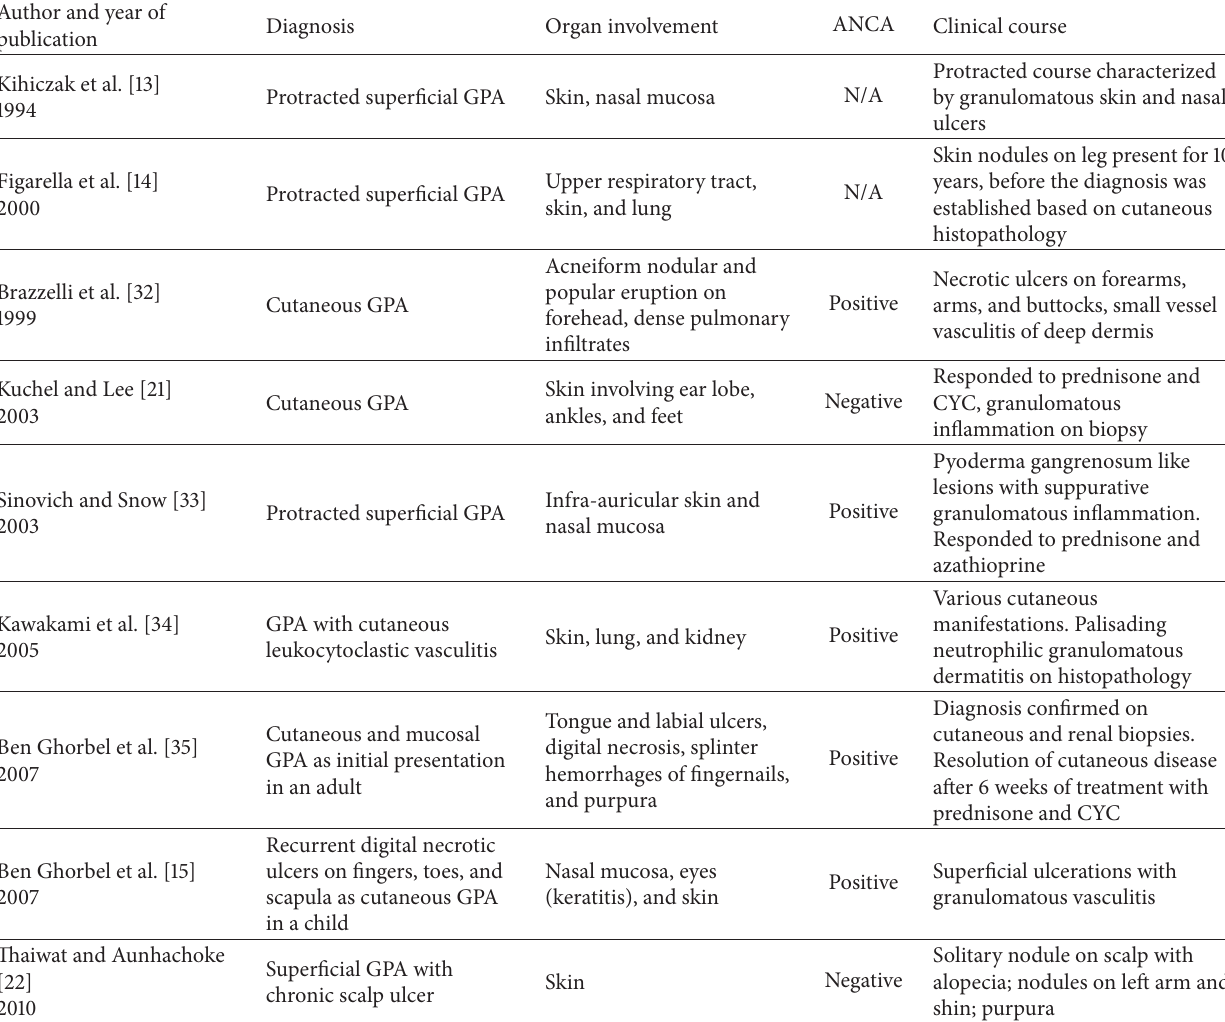
Table 2: Case reports of localized GPA with cutaneous